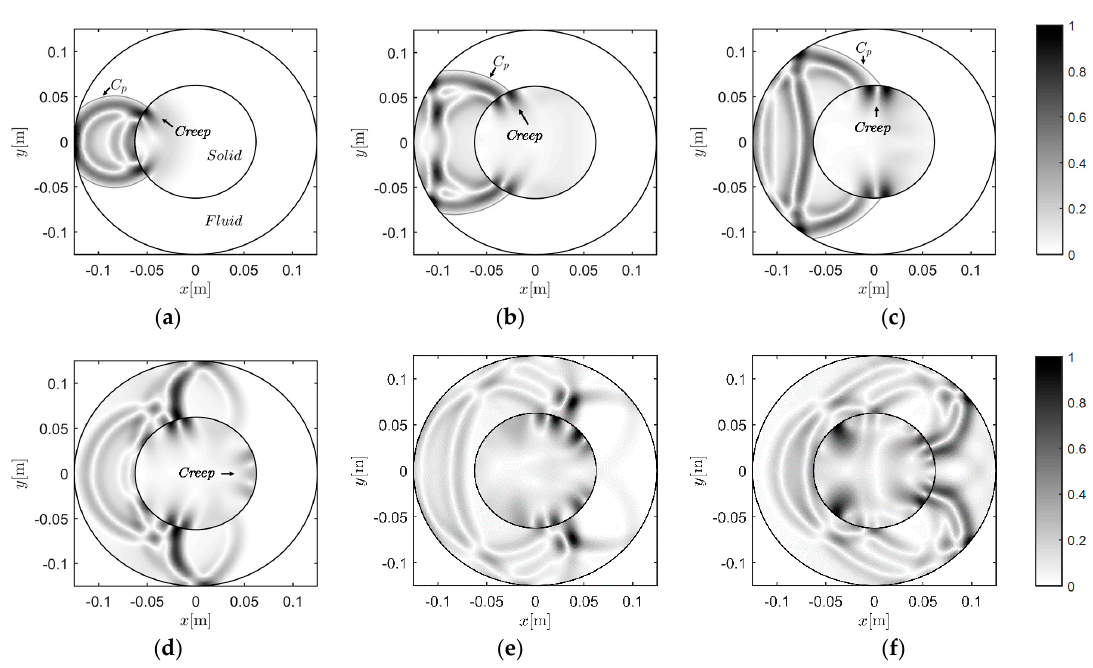
Figure 10. Snapshots of the wavefield induced by the source at − 0.0833 m and 0 m: ( a ) 35 μ s, ( b ) 45 μ s, ( c ) 55 μ s, ( d ) 75 μ s, ( e ) 95 μ s, and ( f ) 115 μ s.